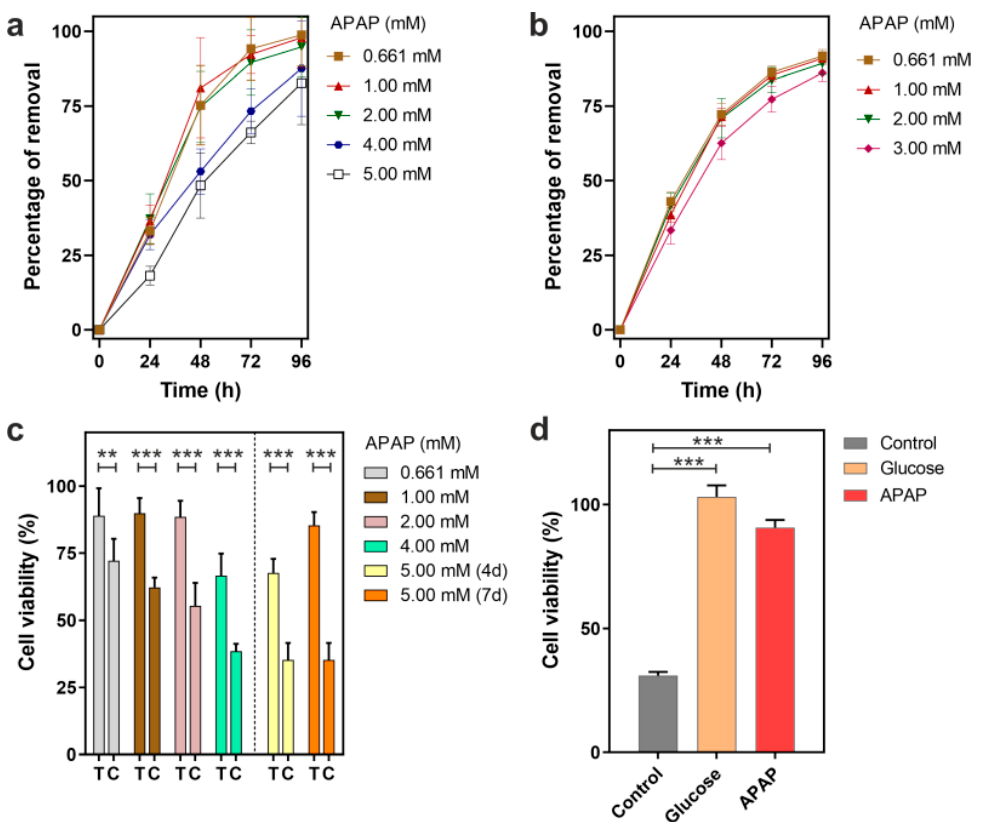
Figure 1. Removal of acetaminophen (APAP) by P. chrysogenum var. halophenolicum and determina- tion of the toxic effect over HepG2 cell line. ( a ) Percentage of APAP removal by P. chrysogenum var. halophenolicum under cometabolism with glucose. ( b ) Percentage of APAP removal when used as the sole carbon source by the fungal strain. ( c ) Cell viability determination of the hepatoma HepG2 cell line when exposed to different APAP concentrations before (C) and after treatment with the fungal strain (T), and fungal cultures from cometabolism after 4 days (4 d) and 7 days (7 d). ( d ) Comparison of the effects of the bioremediation of APAP used as carbon source by P. chrysogenum var. halophenolicum quantified as the viability of HepG2 cell line: Control, 2.00 mM APAP; Glucose, fungal culture with an initial concentration of 1.5 mg/mL glucose; APAP, fungal culture with an initial concentration of 2.00 mM APAP. Statistical significance of the comparisons calculated with Student’s t-test was depicted by asterisks: *, p -value < 0.05; **, p -value < 0.001; ***, p -value < 0.0001.